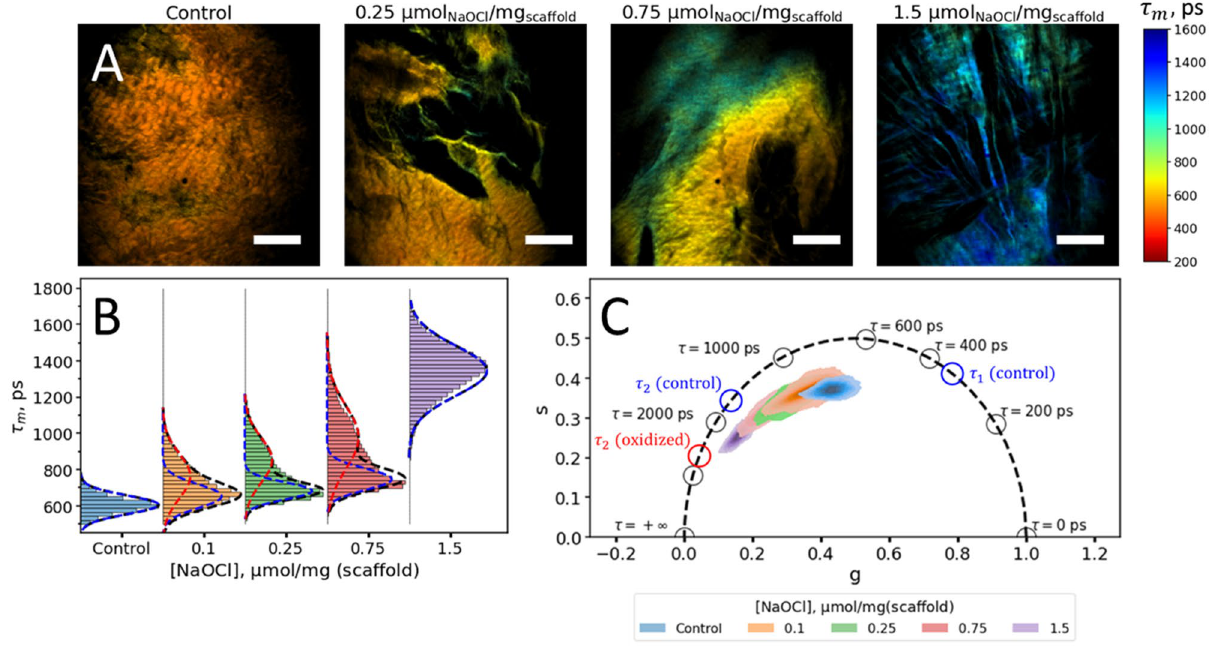
Figure 1. Fluorescence decay parameters of the decellularized bovine pericardium scaffolds cross-linked with genipin (DBP-G) treated with sodium hypochlorite. ( A ) Average fluorescence lifetime (τ m ) maps of the control DPB-G scaffold and DPB-G scaffolds, treated with 0.25, 0.75, 1.5 µmol (NaOCl)/mg (scaffold). ( B ) Histogram distributions of the average fluorescence lifetime τ m for DPB-G samples treated with different concentrations of sodium hypochlorite. The experimental fluorescence lifetime distributions were fitted by Gaussian distribution (control sample and sample treated with 1.5 μmol (NaOCl)/mg (scaffold)) or by a mixture of two Gaussian distributions. Blue and red dashed lines represent the respective components in the mixture, while black dashed lines represent the overall fit. ( C ) Phasor-plot of FLIM data for scaffolds treated with various concentrations of sodium hypochlorite. Blue and red circles indicate the fluorescence averaged decay lifetimes τ 1 and τ 2 of the control DBP-G sample and DBP-G treated with 1.5 μmol (NaOCl)/mg (scaffold) estimated using biexponential decay model averaged over all samples and all pixels. Fluorescence was excited at 800 nm and detected in the 350–680 nm range. Scale bars in panel ( A ) equal to 150